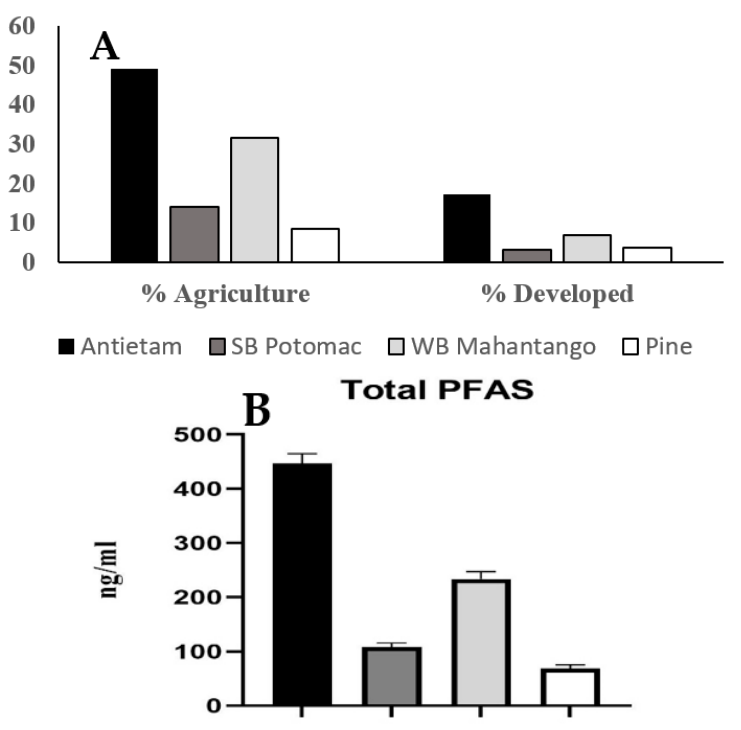
Figure 3. ( A ) Pattern among the sites in % agriculture and % developed land-use in the upstream catchment. ( B ) Pattern of total PFAS compounds measured in smallmouth bass plasma.